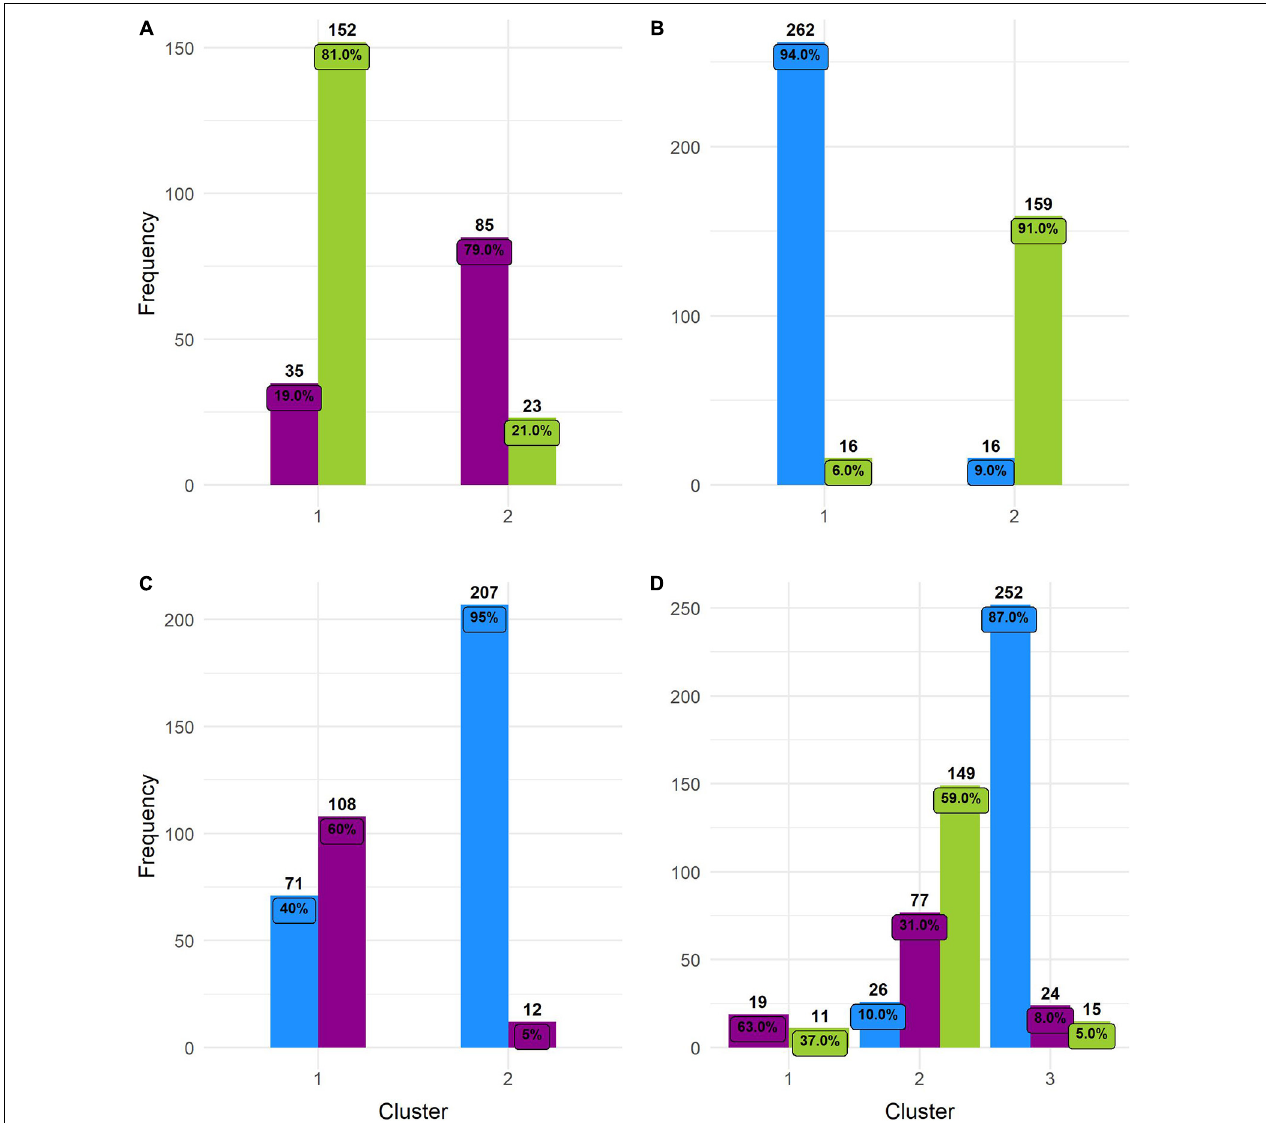
FIGURE 7 | Histograms of k -means clustering results. Numbers above bars = total number of individuals grouped in a particular cluster. Numbers inside bars = percentage. (A) Wild and feral; (B) wild and domesticated; (C) feral and domesticated; and (D) the three cotton groups. Wild = green, feral = magenta, and domesticated =